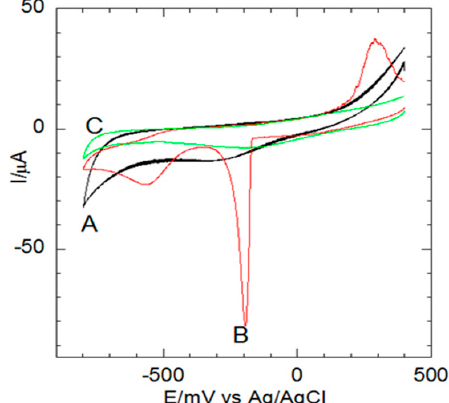
Figure 3 . Cyclic voltammetric traces for: ( A ) GCE  SDD–Co(II)  (black); ( B ) GCE  SDD– Figure 3. Cyclic voltammetric traces for: ( A ) GCE|SDD–Co(II)|(black); ( B ) GCE|SDD–Co(II)|AgNPs| Co(II)  AgNPs  (red); and ( C ) GCE  SDD–Co(II)  AgNPs  MCLRA (green) in 0.1 M PBS at a 100 mV s − 1 (red); and ( C ) GCE|SDD–Co(II)|AgNPs|MCLRA (green) in 0.1 M PBS at a 100 mV · s − 1 scan scan rate.